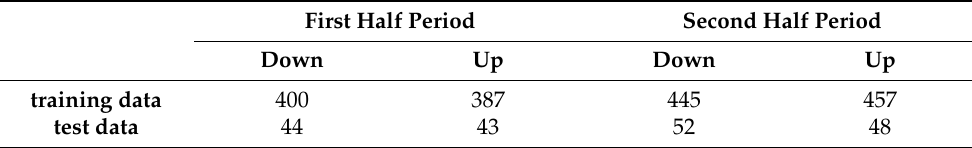
Table 6. Sample size of each